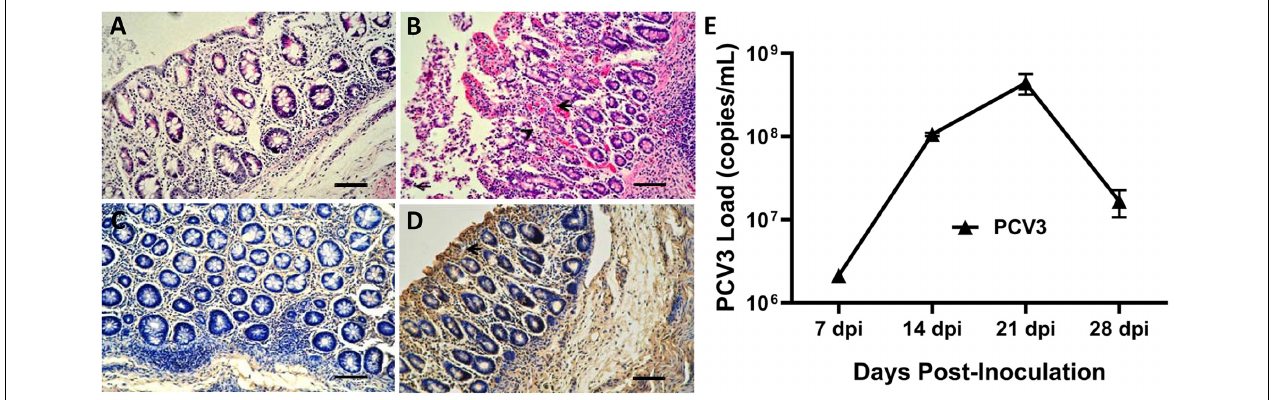
FIGURE 1 | Histopathological lesions and immunohistochemical staining of small intestines and porcine circovirus type 3 (PCV3) loads in sera of PCV3- and sham-inoculated piglets. (A) Normal morphology of a small intestine section from a sham-inoculated piglet. (B) Small intestine lesions from a PCV3-inoculated piglet showed mucosal epithelial cell necrosis and some necrosis of lymphocytes, infiltration of abundant eosinophils and lymphocytes, and small numbers of plasma cells (arrowheads). (C) No staining was observed in the small intestine section from a sham-inoculated piglet. (D) Several PCV3 antigen-positive cells (arrowhead) were also observed in the small intestine of a PCV3-inoculated piglet, which were stained brown. Bars, 80 µ m. (E) Viral loads in sera were quantitatively assayed by real-time PCR in PCV3-inoculated piglets. The values presented are the means of the results from the four PCV3-inoculated piglets at 7, 14, 21, and 28 dpi. Error bars indicate standard